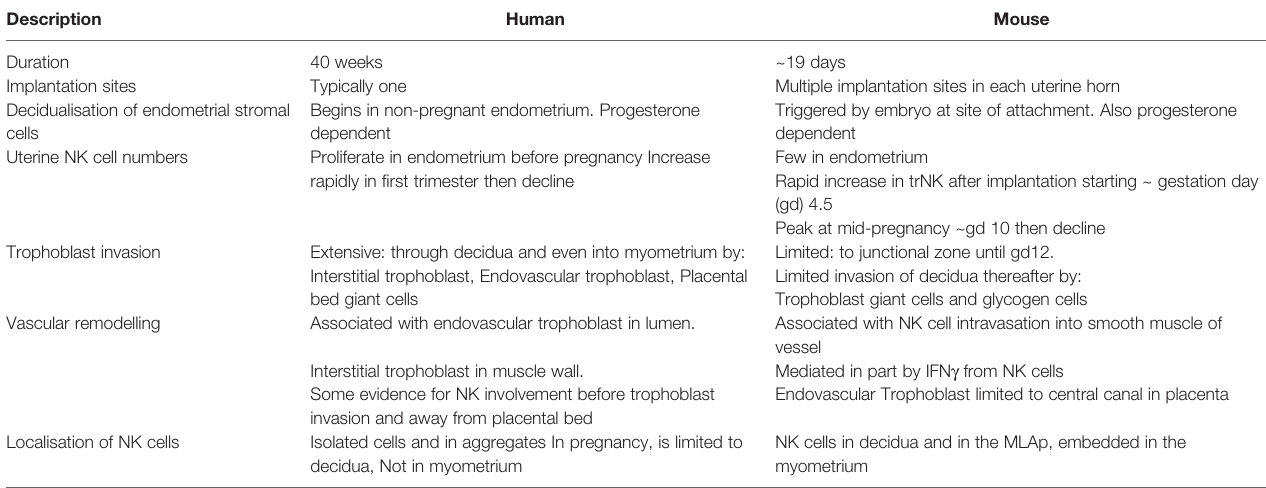
TABLE 2 | Key Features of human and murine pregnancy